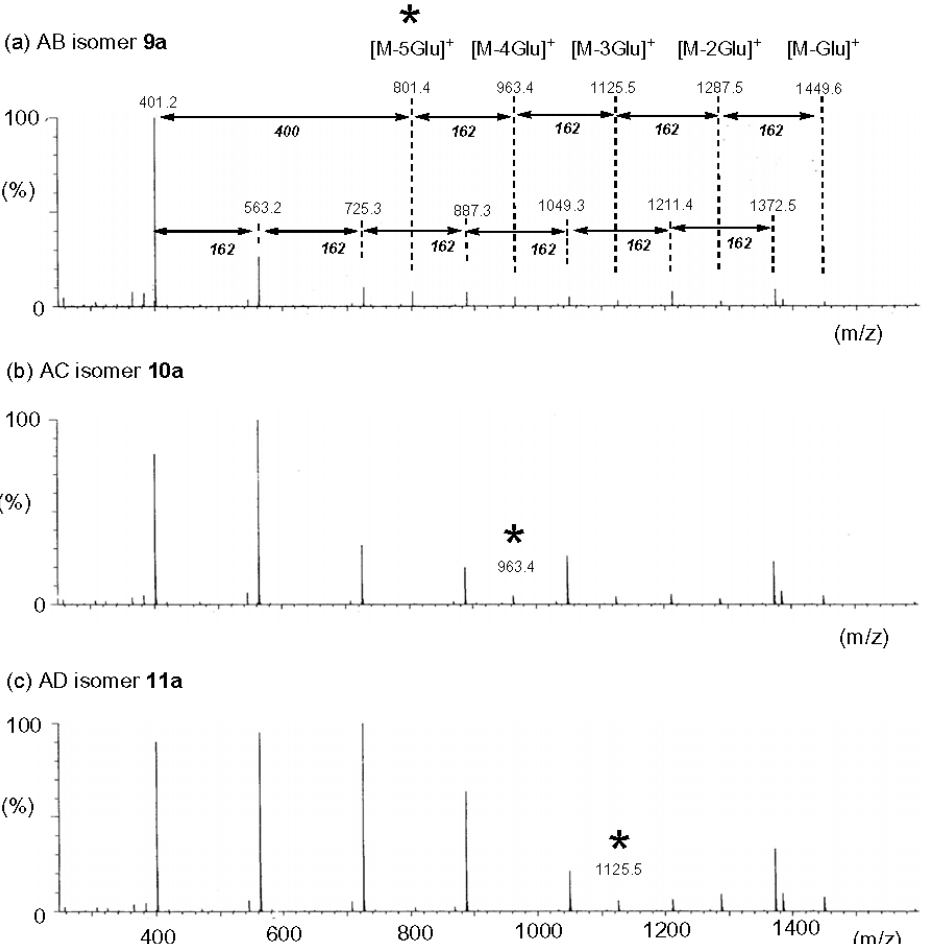
Figure 11. ESI CID MS 2 of [M + H] + ( m / z 1612.5) of three regioisomes of di-6,6 (cid:48) - N,N (cid:48) -(bis(picolyl)glycylamido)- β -CDs 9a – 11a ( a – c ). The characteristic peaks of fragment ions are marked with asterisks (reproduced from [15] with permission of SAGE Publications Ltd.).